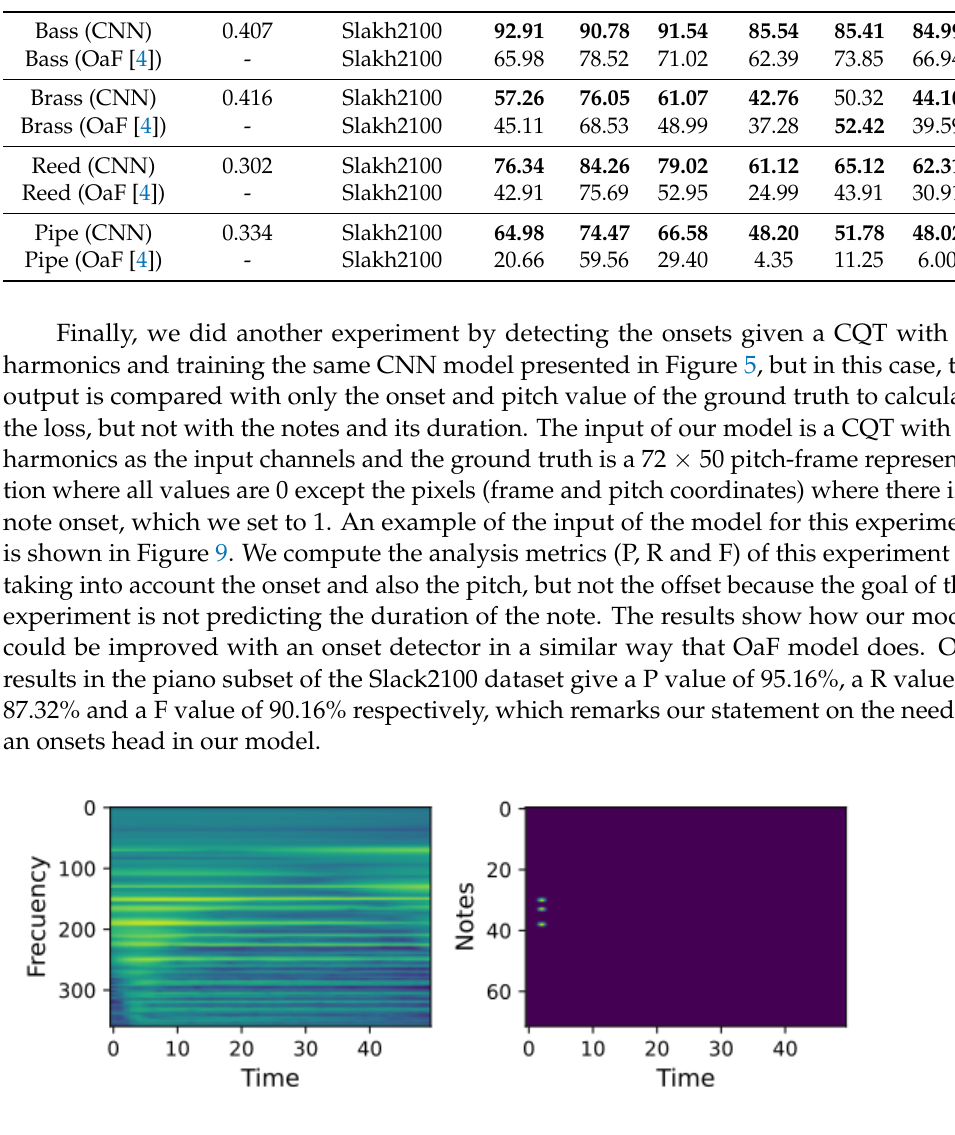
Table 4. Transcription metrics of our second model (CNN) in comparison with Onsets anf Frames model trained with Maestro dataset. Best result for every metric is highlighted in bold. Instrument